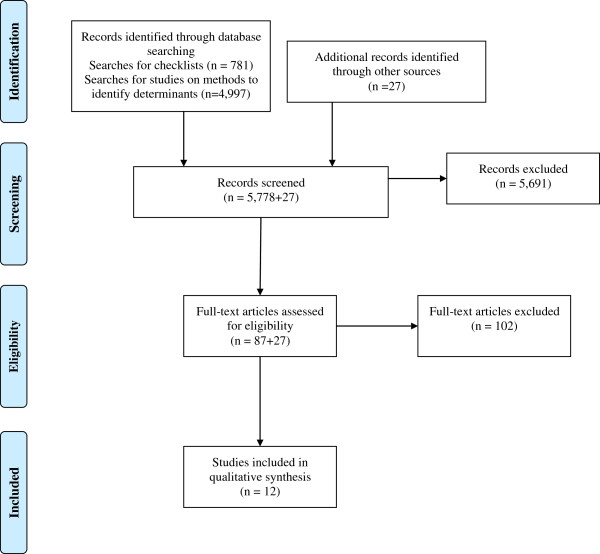
Study selection.